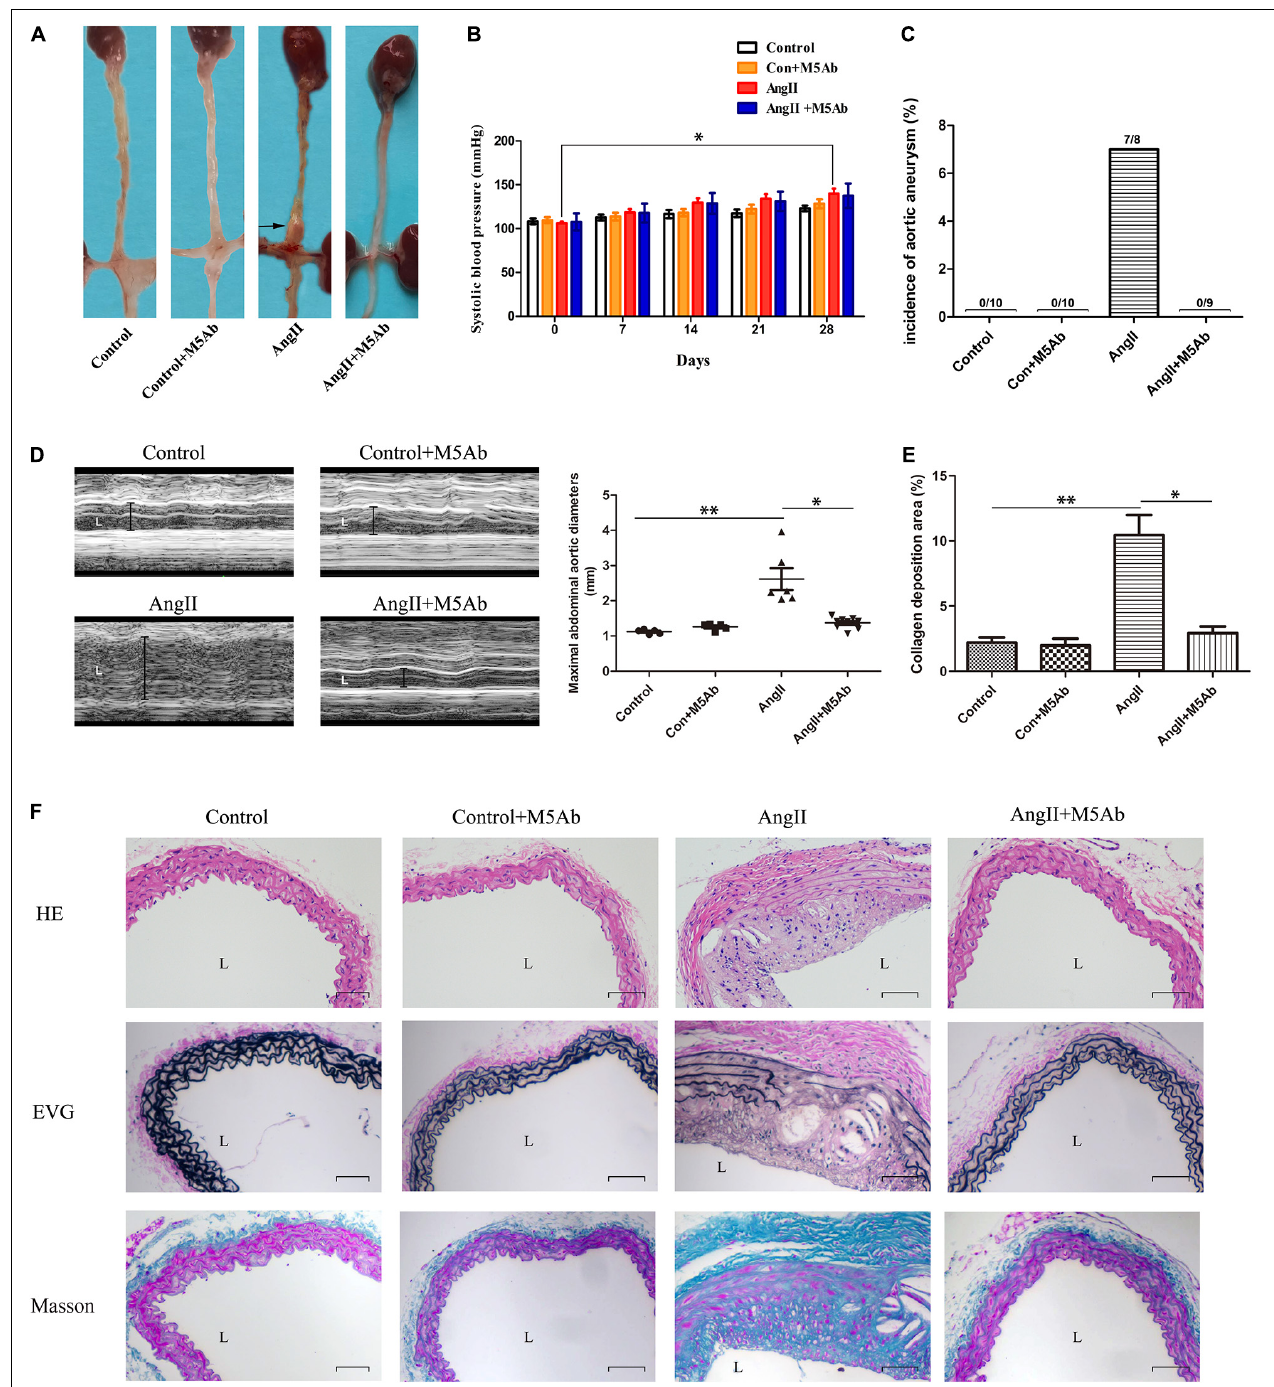
FIGURE 3 | Characteristics of AngII-induced AAA model ultrasonography and baseline. (A) Representative the macroscopic features of abdominal aorta in the four groups. (B) The SBP was measured by tail-cuff weekly in the four groups. Baseline blood pressure was not different. Compared with that on the 0th day, the SBP in the AngII group increased on the 28th day, which was statistically significant (123 ± 3.25 mmHg vs 139 ± 5.83 mmHg, * P < 0.05, two-way ANOVA), while the SBP among the four groups was not statistically significant in the weekly comparison (P > 0.05, two-way ANOVA). n = 5 per group. (C) Percentage of mice in which aortic aneurysm was successfully achieved in the four groups. (D) Representative the ultrasonography images (left) and the data of maximal abdominal aortic diameters (right) in the four groups at the end of 28 days. (E,F) The histological analysis (H&E, EVG, and Masson’s trichrome staining) of abdominal aorta of mice under different treatments for each condition (Scar bar 100 µ m). Statistical analysis of collagen deposition. * P < 0.05 vs the Ang II + M5Ab group; ** P < 0.05 vs the control and control + M5Ab groups. Abbreviations: H&E, hematoxylin and eosin; and L, lumen. Data are expressed as means ± SEM; n = 3 per group.